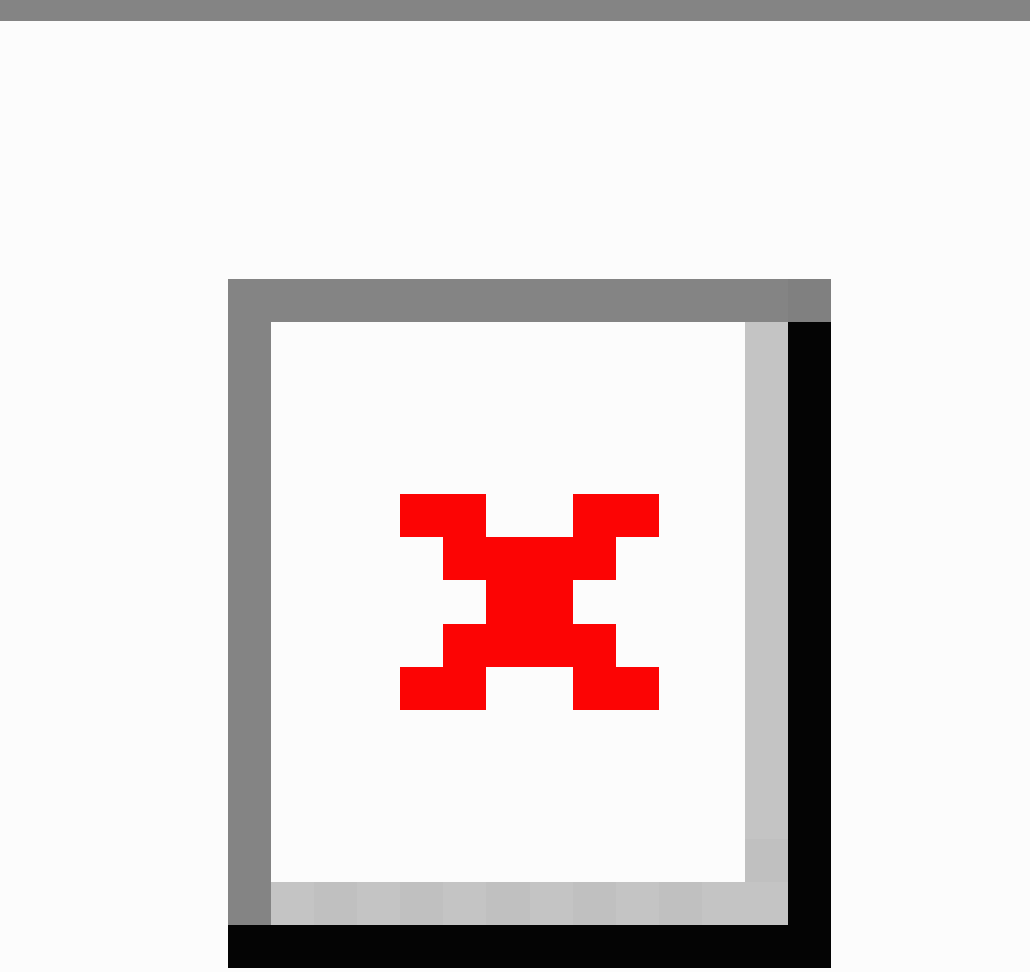
Figure 5. Patient opinion about the app design in terms of color, text and button size, content, and the amount of content per page (scale from 1 = “I like it” to 6 = “I don’t like